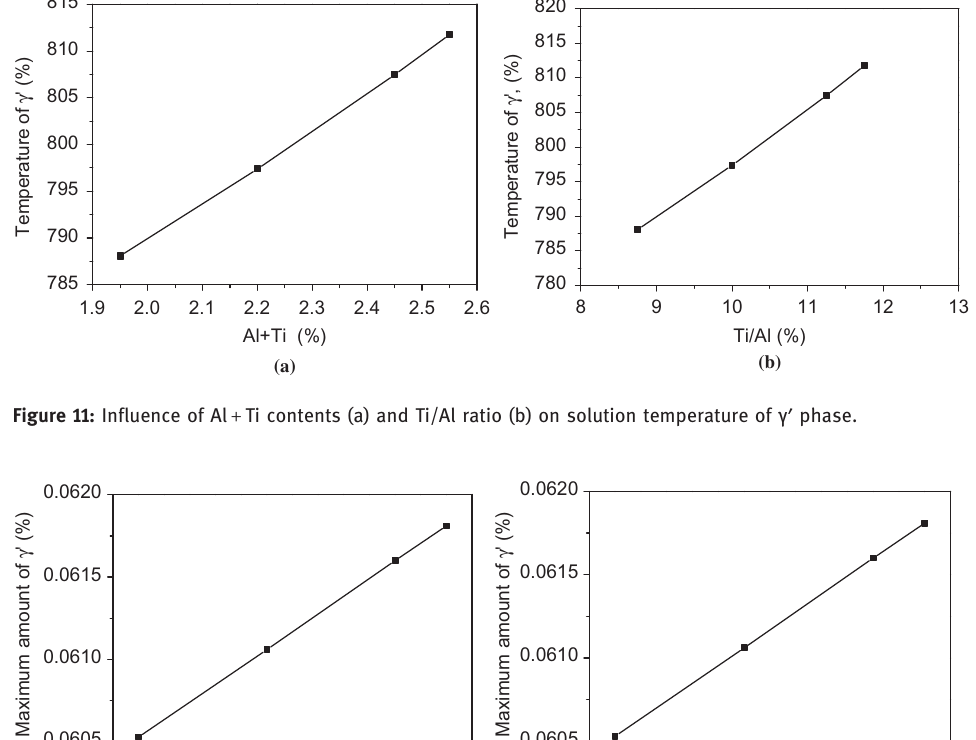
0.06050.06100.0615